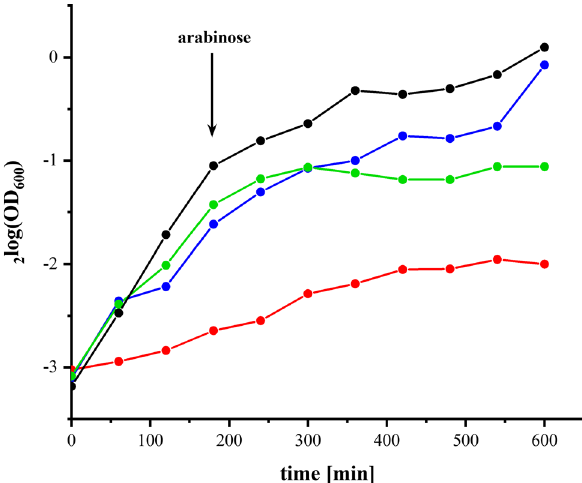
Figure 2. Growth of deletion strain BW25113 ∆ndh nuo:nptII_FRT (red) and strains BW25113 ∆ndh nuo:nptII_ FRT /pBAD nuo His (black), BW25113 ∆ndh nuo:nptII_FRT /pBAD nuo His nuoF D213G H (blue) and BW25113 ∆ndh nuo:nptII_FRT /pBAD nuo His nuoF V259A L (green) in minimal medium with acetate as sole carbon source. The black arrow indicates the induction of gene expression after 3 h growth by an addition of 0.02% arabinose.